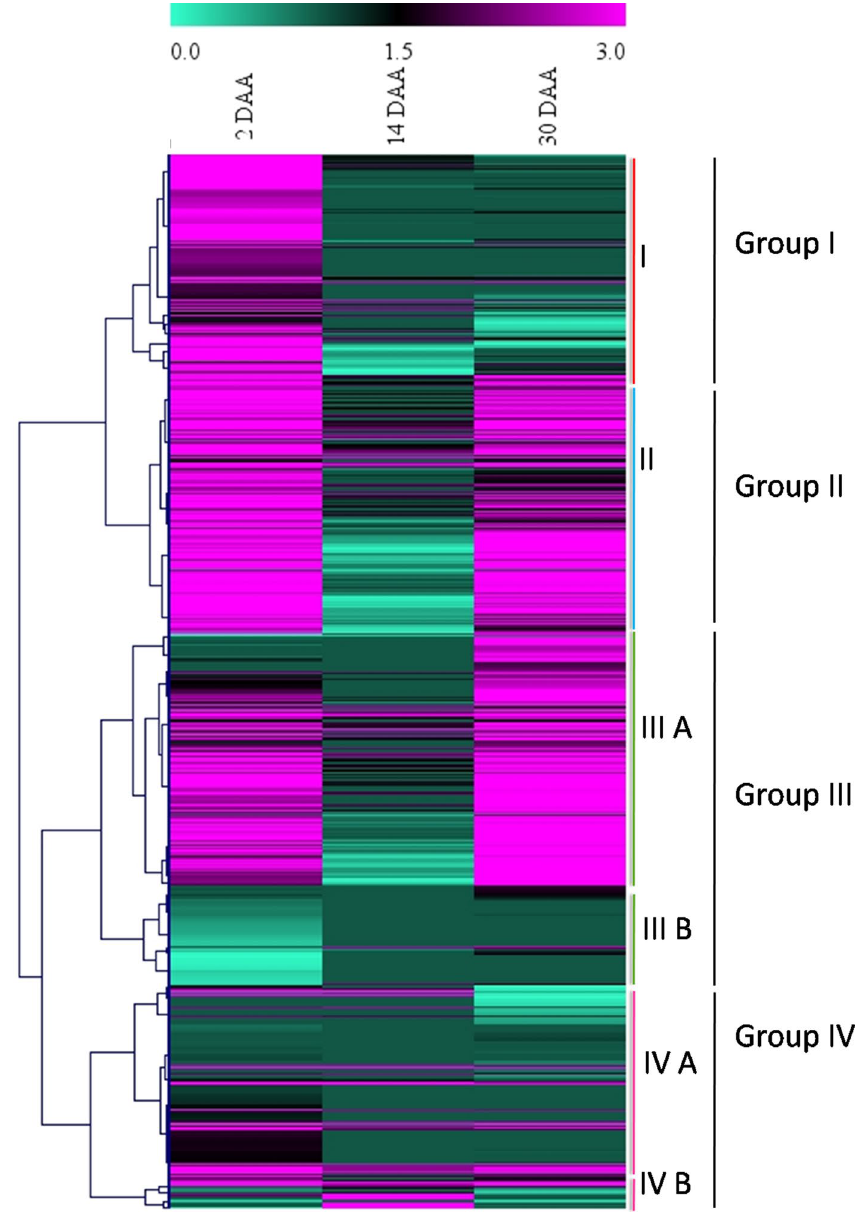
Figure 5. Expression profiles of 698 wheat RING protein genes at three seed developmental stages (2, 14, and 30 day after anthesis, DAA). The data was extracted from RNA-seq data set (https:// wheat. pw. usda. gov/ GG3/ node/ 237), clustered expression heat map generated by MeV software version 4.9.0 and divided into four major groups according to gene expression patterns represented as color gradient. The color scale indicating largest gene expression values in pink color, intermediate values in black color and the smallest values in green